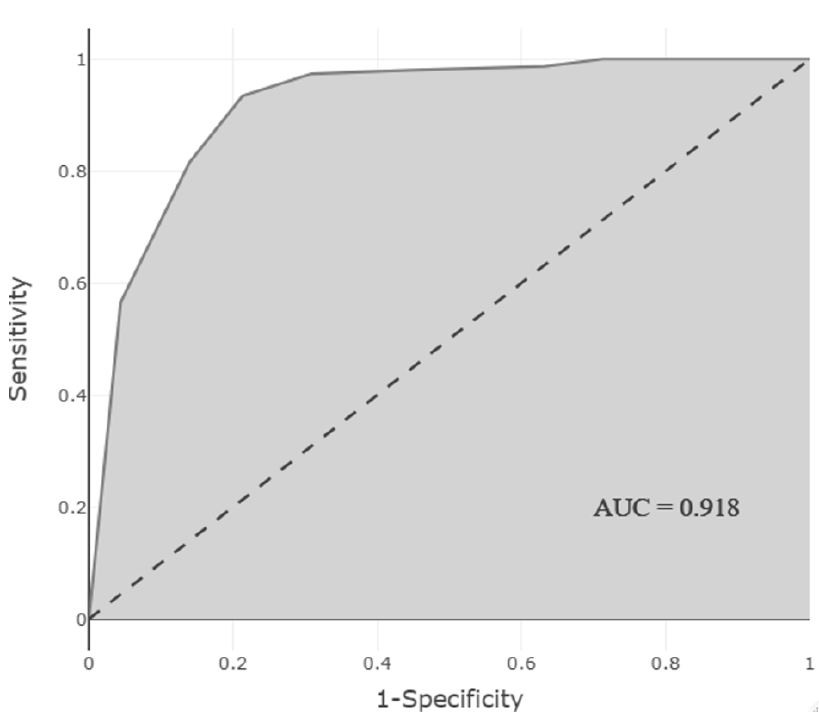
Figure 1. AUC-ROC curve showing the performance of the model predicting the presence of ADRs . Using the data of all patients, a significant positive correlation was obtained between the new ADRs risk score obtained by logistic regression and the mean risk correlation coefficient per ADR obtained from the risk matrix (Spearman rho = 0.657, p < 0.001). This shows that the mean risk per ADR and the new risk score were compatible with each other, and that the new ADR risk score obtained can be used reliably in clinical